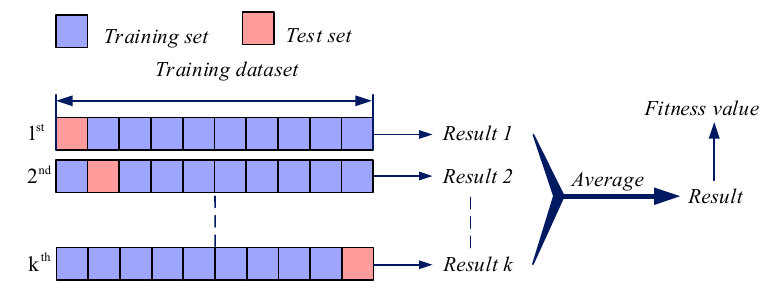
Figure 6. K-fold cross-verification flow chart.